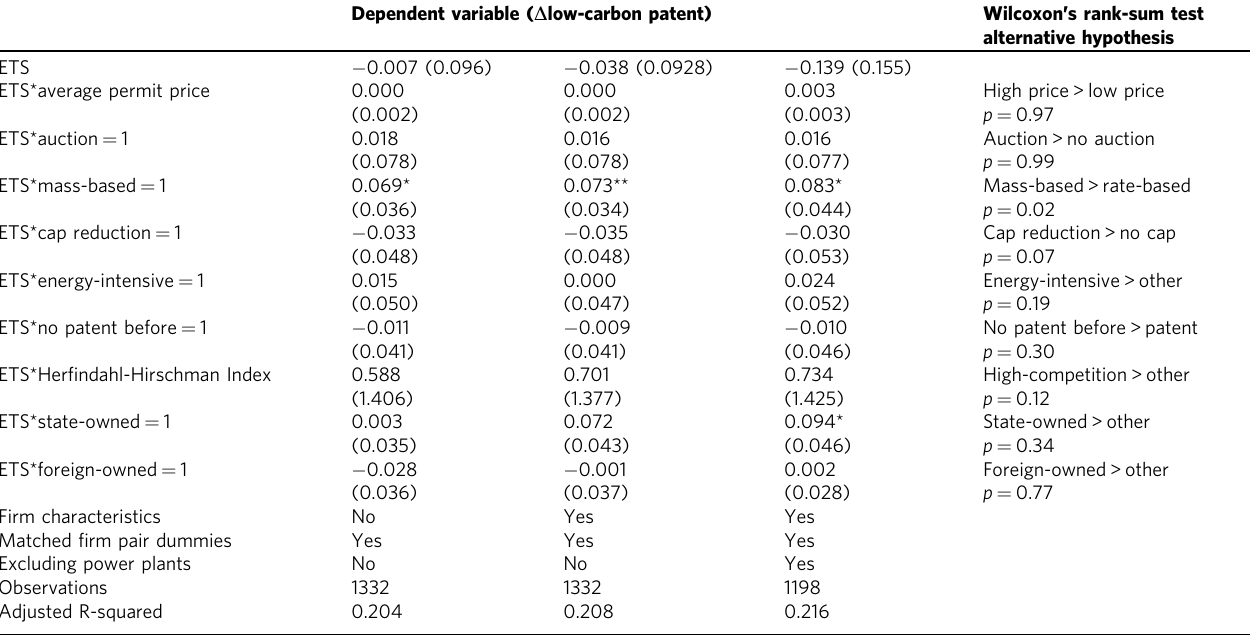
Table 2 Heterogeneous effects of the ETS across programs and fi rms Dependent variable ( Δ low-carbon patent)